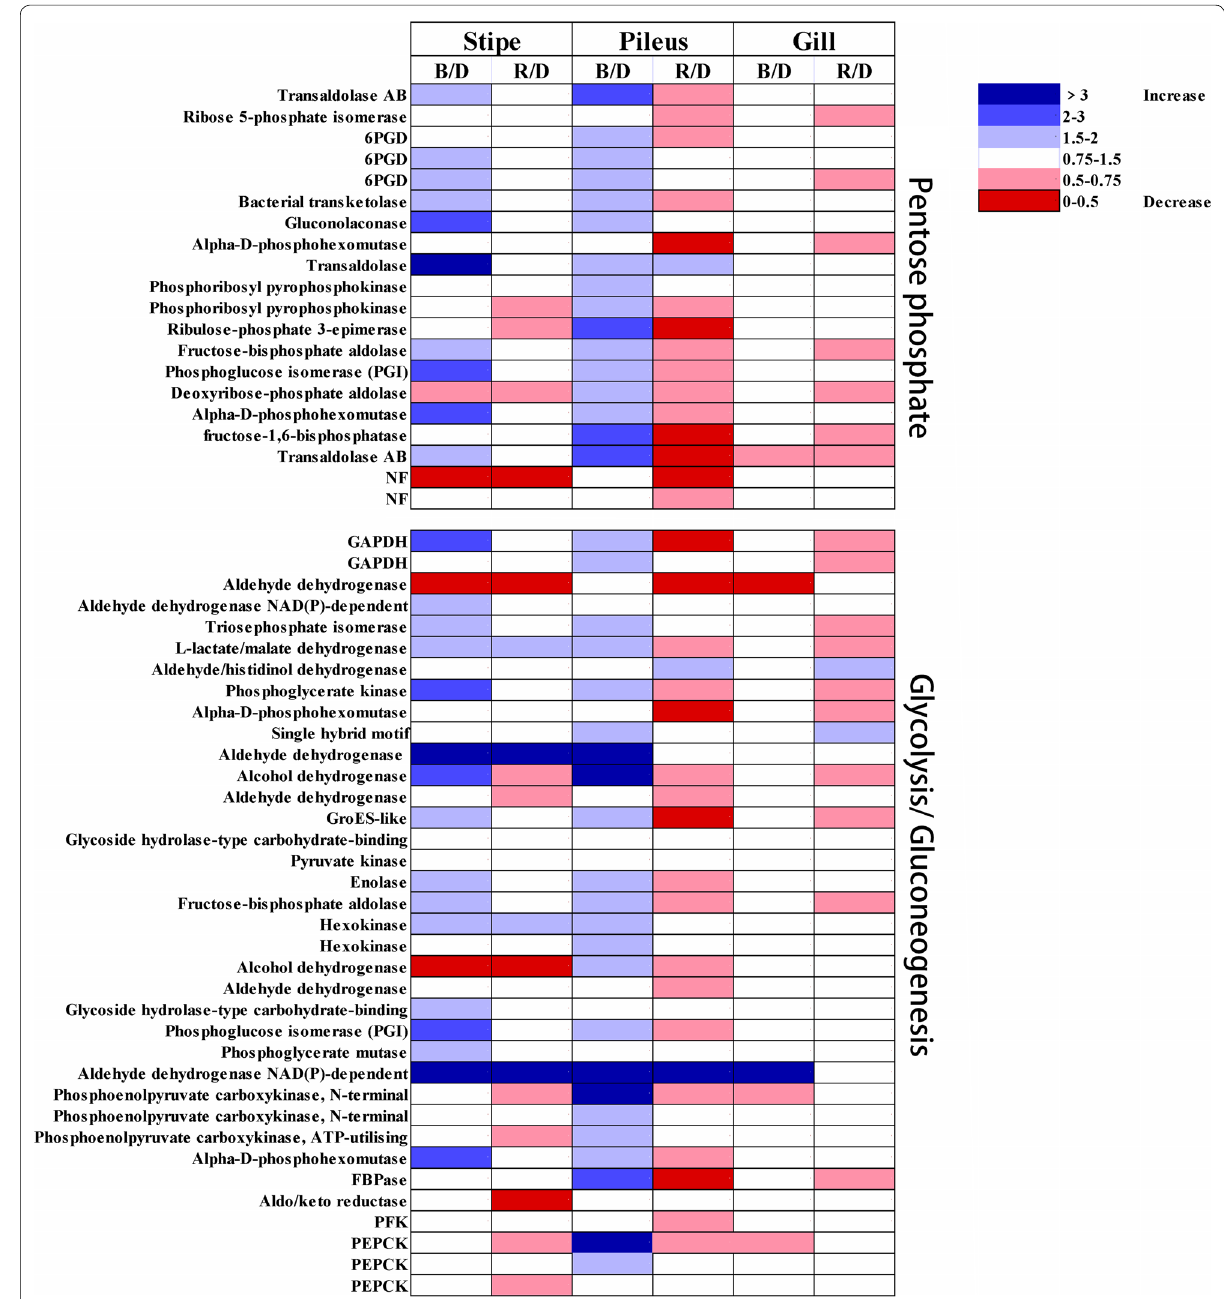
Fig. 4 Fold changes of all the expressed genes involved in the pentose phosphate pathway and glycolysis/gluconeogenesis. FPKM values of all the genes involved in the pentose phosphate pathway and glycolysis/gluconeogenesis were used to calculate the fold changes between blue-light treatment/dark treatment (B/D) as well as red-light treatment/dark treatment (R/D). GAPDH, glyceraldehyde-3-phosphate dehydrogenase; PFK, 6-phosphofructokinase; 6PGD, 6-phosphogluconate dehydrogenase; PEPCK, phosphoenolpyruvate